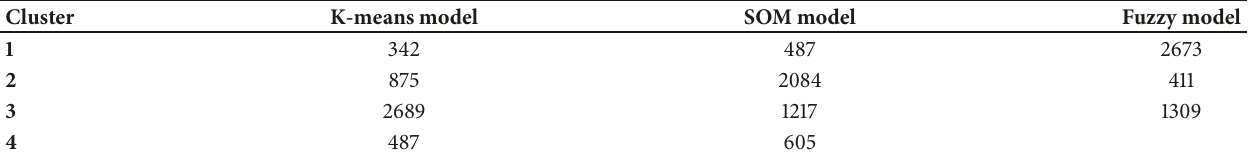
Table 2: Cluster densities (number of households allocated to the cluster) for the Ethiopia dataset. Cluster